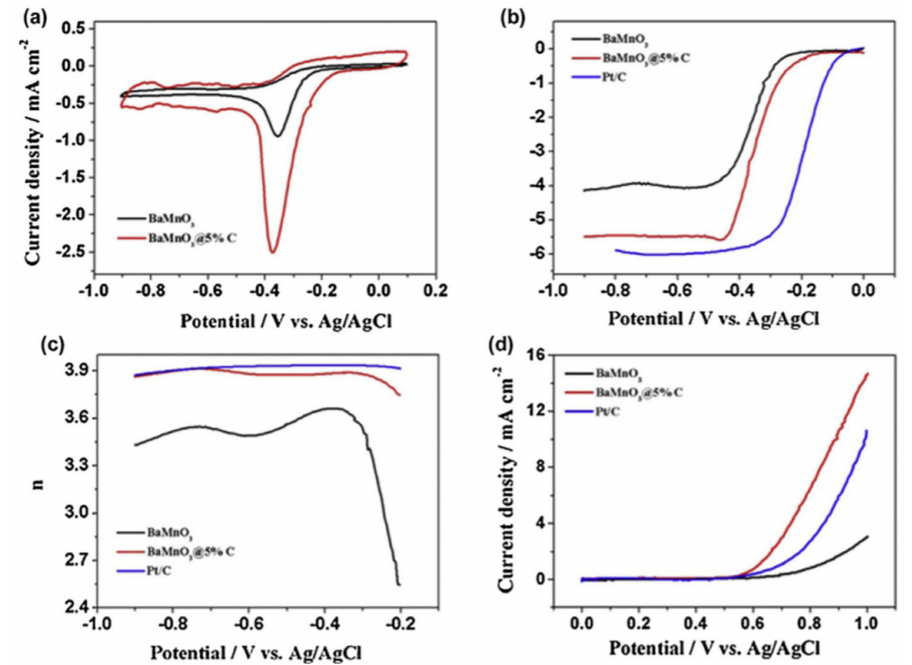
Figure 9. ( a ) Cyclic voltammetry; ( b ) linear sweep voltammogram, BaMnO 3 (black curve) BaMnO 3 @ 5% C (red curve) in O 2 saturated 0.1 M KOH solution, commercial Pt/C (blue curve); ( c ) electron transfer rate; ( d ) LSV in N 2 saturated 0.1 KOH solution. (Reprinted with permission from [54]. Copyright 2015,